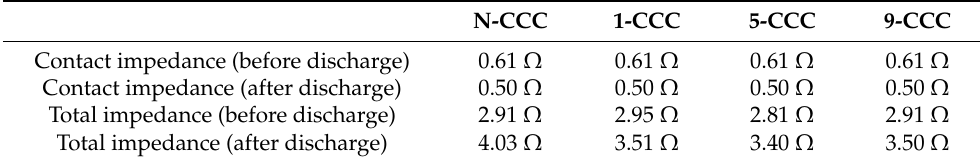
Table 2. Impedance of µ DMFC with different gradient wettability